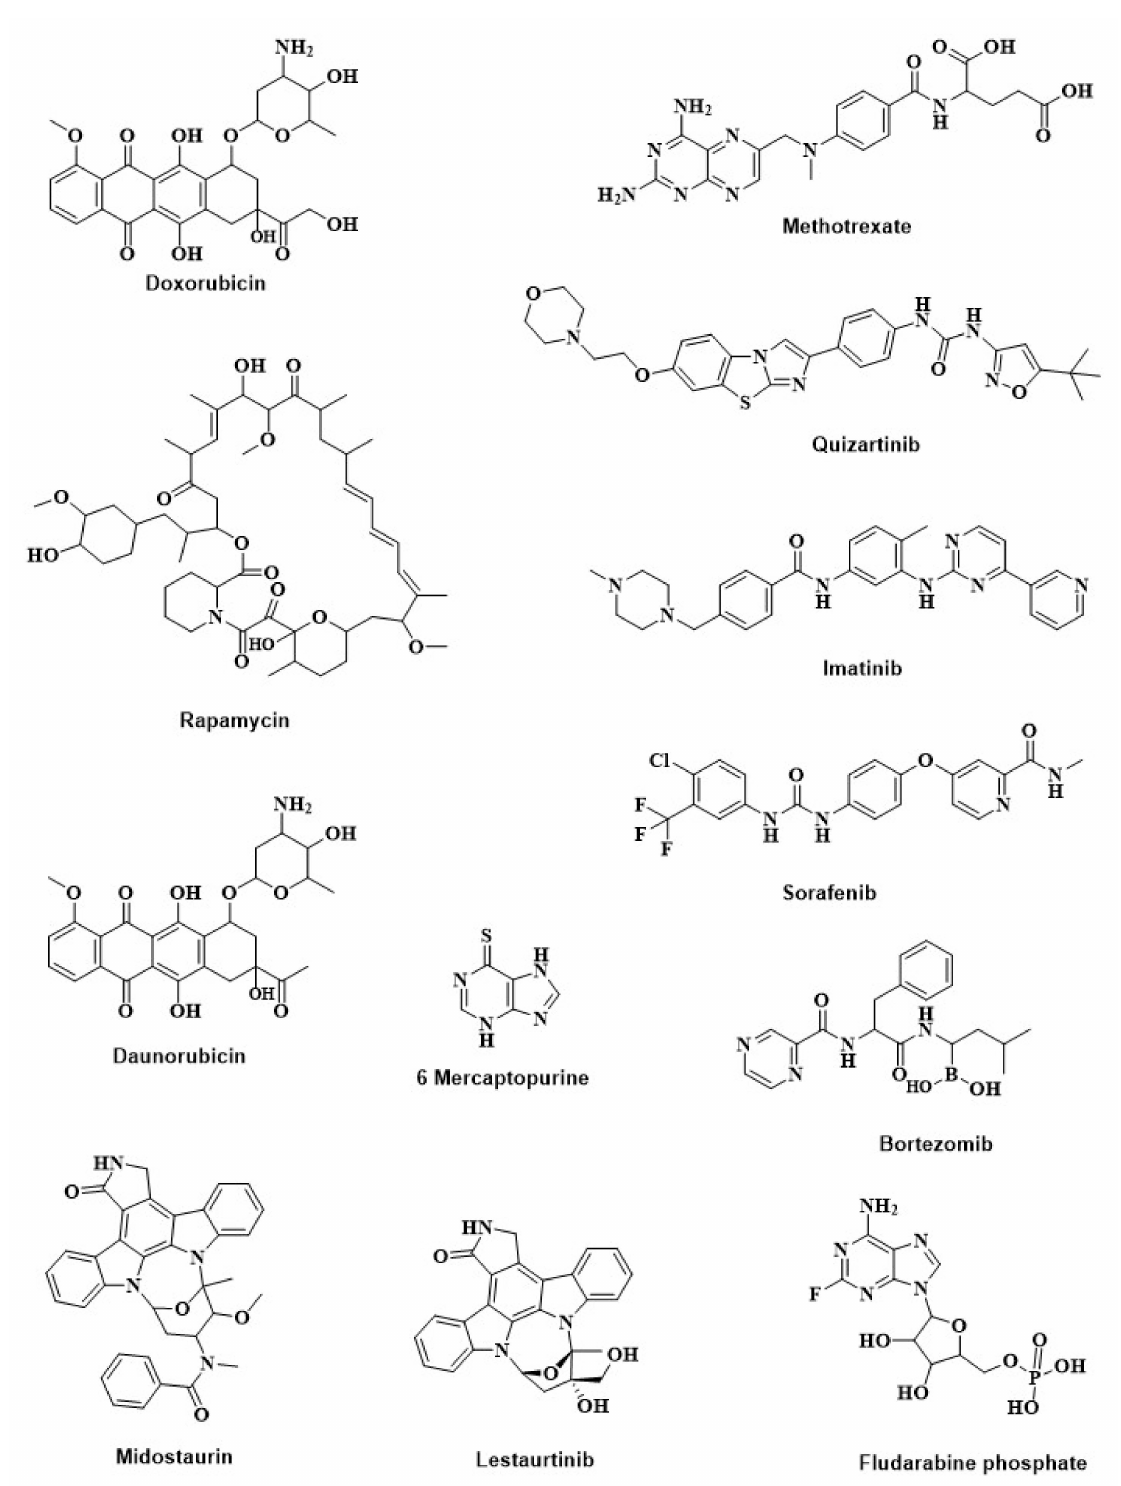
Figure 10. Structure of chemotherapeutic drugs used in HMs treatment. GNMs-conjugation improved the anticancer activity and selectivity of the chemotherapeutic drugs. Hematological malignancies: HMs; Gold nanomaterials: